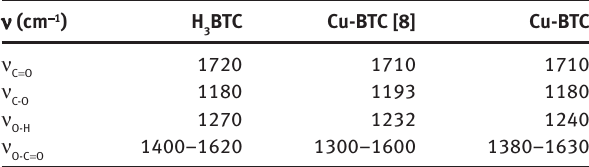
Table 2: The vibration group of CuBTC, formed from Cu and